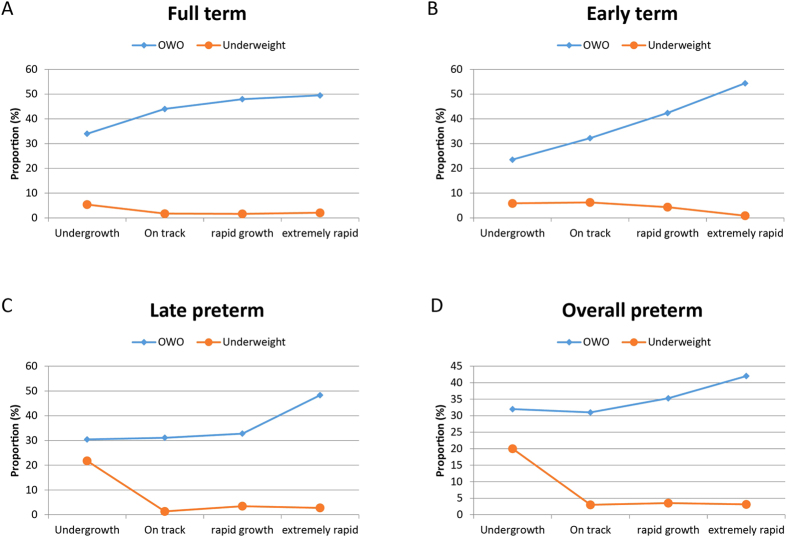
The relationship between weight gain z-score in the first 4 months of life and the percentage of underweight and overweight or obesity at age 2–7 years stratified by gestational age category.Gestational age category was defined as full term (gestational age ≥39 weeks), early term (37–38 weeks), late preterm (34–36 weeks), and early preterm (<34 weeks). Full term (panel A); early term (panel B); late preterm (panel C); overall preterm (panel D).